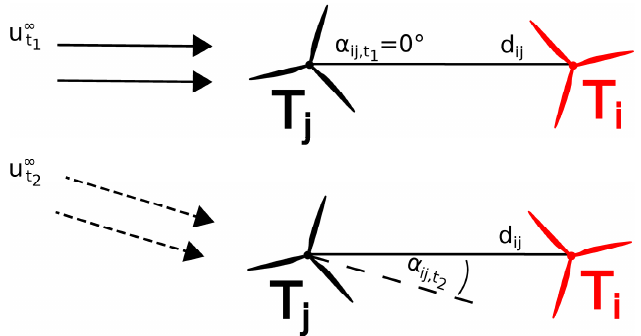
Figure 1. Explanation of the turbine alignment angle (cid:2009) (cid:3036)(cid:3037),(cid:3047) and distance (cid:1856) (cid:3036)(cid:3037) for two wind